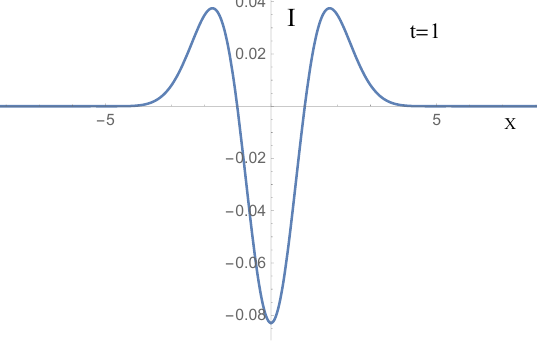
Figure 3. Extra-current, I ( t , x ) = ∂ t ρ ( t , x ) + ∂ x j ( t , x ) , in the spreading of a Gaussian wave packet according to the non-local Equation (17). The value of I is shown as a function of x at the instant t = 1. All units have been rescaled with the definition ¯ h = m = 1. The regions of negative I are those where there is charge depletion (or more generally probability depletion) without a corresponding current, and conversely for the regions of positive I . The spreading of the wave packet is accelerated, compared to the case of locally conserved charge and I = 0. The curve shown in this figure represents a perturbative solutions of the wave equation, at first order in the coupling U 0 . For any fixed time, I ( t , x ) can be expressed in terms of elementary functions and Bessel